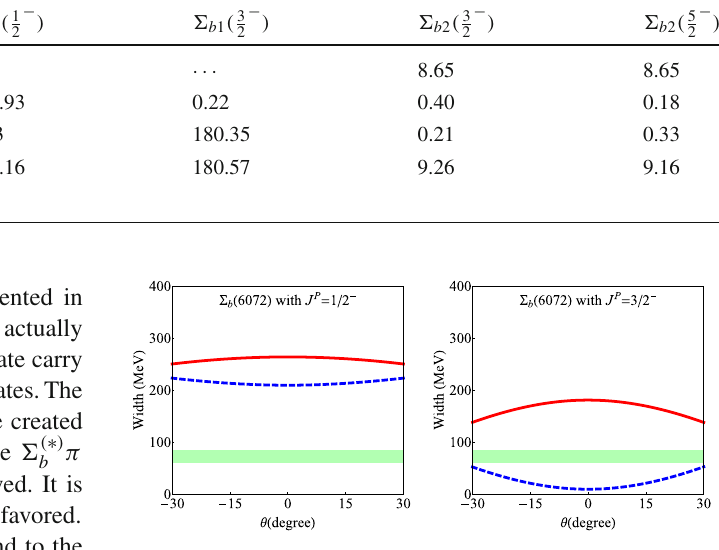
Table 3 Decay widths of the (cid:4) b ( 6072 ) as (cid:4) b ( 1 P ) states in MeV Decay mode